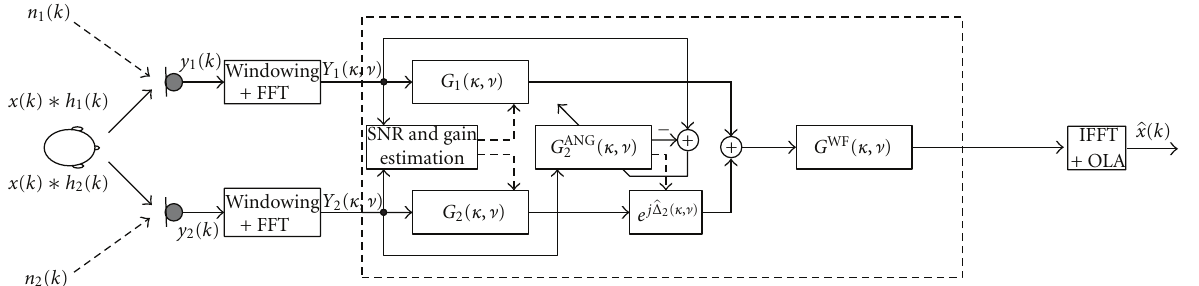
Figure 8: System structure of the blind-matched filtering with noise reduction for two channels.